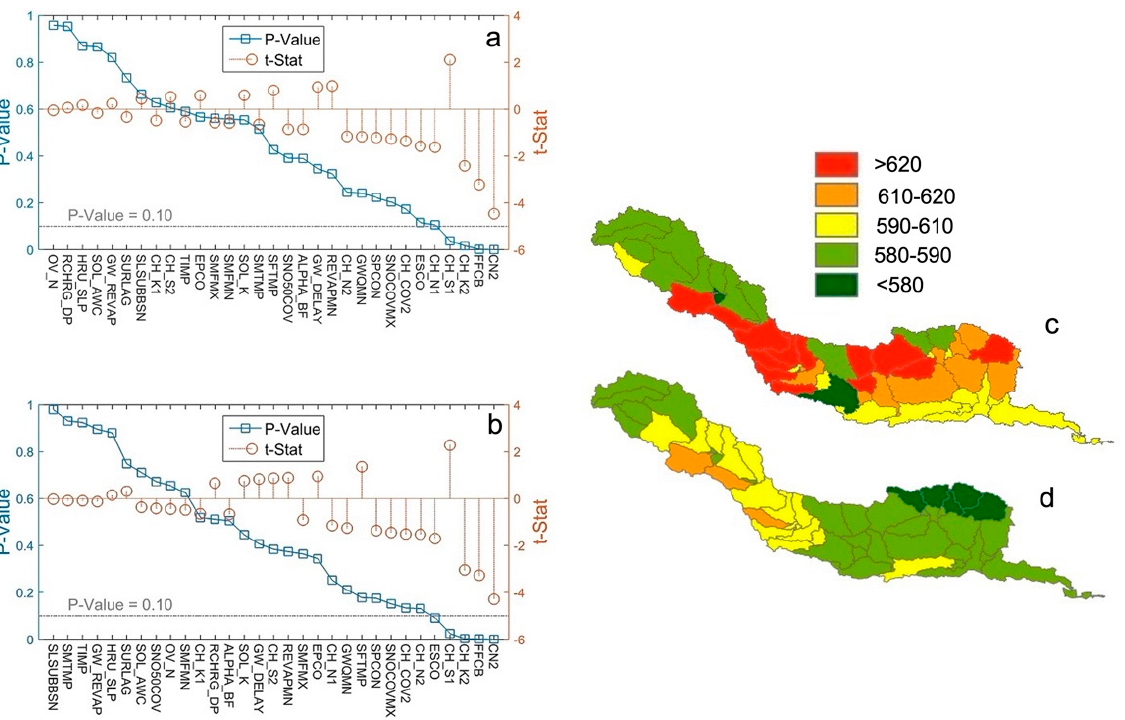
Figure 5. Sensitivity analysis of simulated streamflow using ( a ) rain gages and ( b ) radar forcings; annual mean actual evapotranspiration of the Shell Creek model prior calibration using ( c ) rain gage and ( d ) radar forcings precipitation.